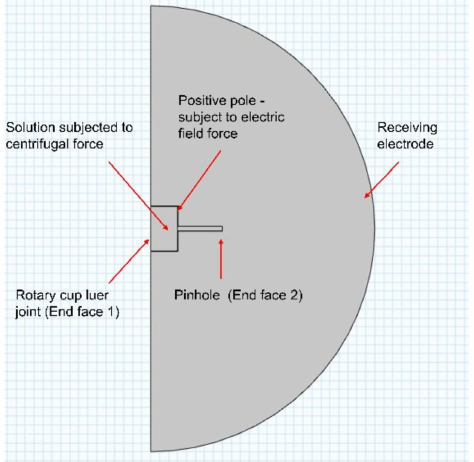
Figure 2. Schematic diagram of setting the boundary conditions for the simulation of the motion state of the polymer jet under the action of the centrifugal electrostatic multiphysics field.